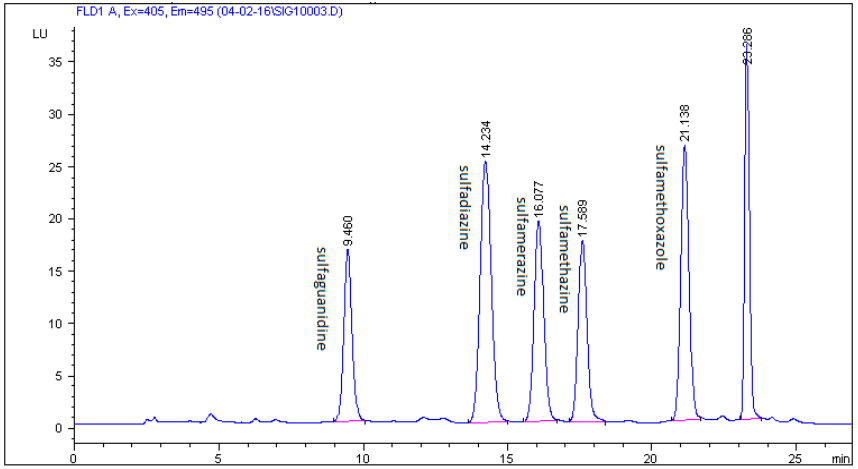
Figure 6. Chromatogram of feed sample spiked with five SAs at a concentration of 200 µg/kg on a Zorbax Eclipse XDB C18 column with a mobile phase of 0.1% formic acid in Milli-Q water/acetonitrile/methanol. 2.3. Method Validation In light of the lack of guidelines related to the validation protocol for the detection of antimicrobials in feed by HPLC-FLD, a validation protocol was established to prove that method performance was fit for the purpose, taking into account the requirements of Commission Decision 2002/657/EC [23]. The evaluated parameters were linearity, selectivity, specificity, sensitivity, repeatability, reproducibility, limit of detection (LOD), limit of quantification (LOQ), decision limit (CC α ), detection capability (CC β ), and uncertainty. Values for recoveries of the spiked samples were in the range of 79.3–114.0% for all analyzed sulfonamides. The intra-day and inter-day precision of the methods were evaluated at three concentration levels (200, 1000, and 2000 µg/kg), in line with the EU Commission Decision. For this purpose, six spiked samples at each level were prepared and analyzed. This procedure was repeated